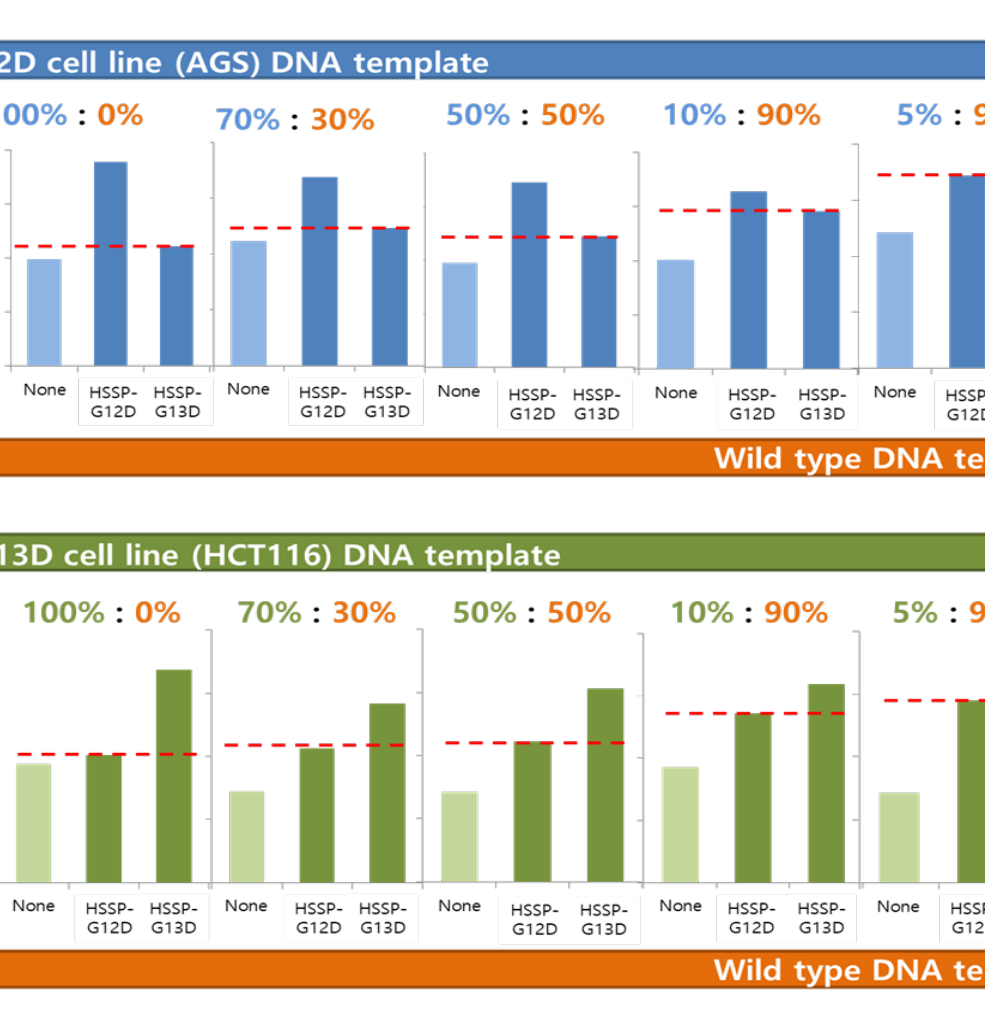
Figure 3. Analysis of the KRAS mutations, with a serially diluted mixed DNA template, using HSSP with qPCR. ( A ) G12D cell line (AGS) DNA template was mixed by serial dilution with wild-type DNA template, and the detection limit of the mutant was checked. ( B ) G13D cell line (HCT116) DNA template was mixed by serial dilution with wild-type DNA template, and the detection limit of the mutant was checked. In both cases, the value was indicated by a red line based on the case of using the non-target HSSP; the C t value using HSSP-G13D in G12D mutation and the C t value using HSSP-G12D in G13D mutation offer visual confirmation of the difference in C t values. Concentrations of 10% and above produce a difference in the C t value, indicating that the mutations can be detected using HSSP with qPCR.